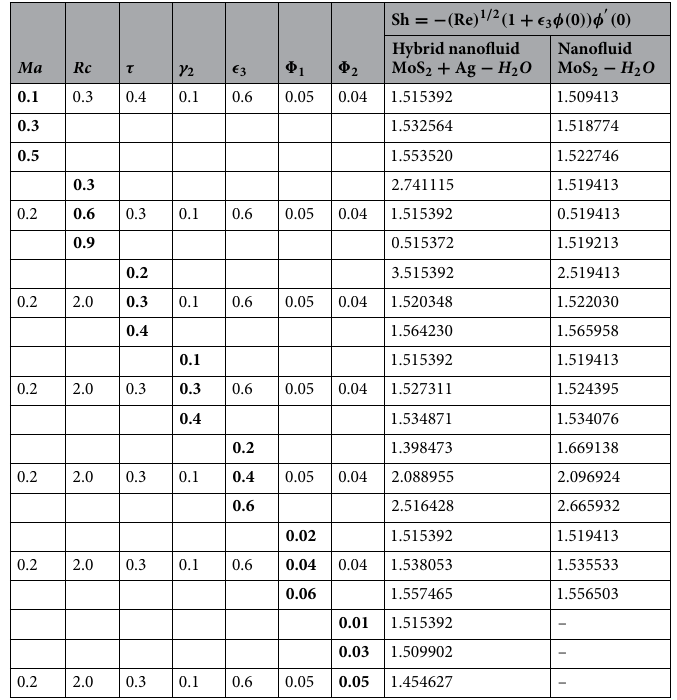
Table 4. Influence of numerous parameters on Sherwood number. Significant values are in [bold].